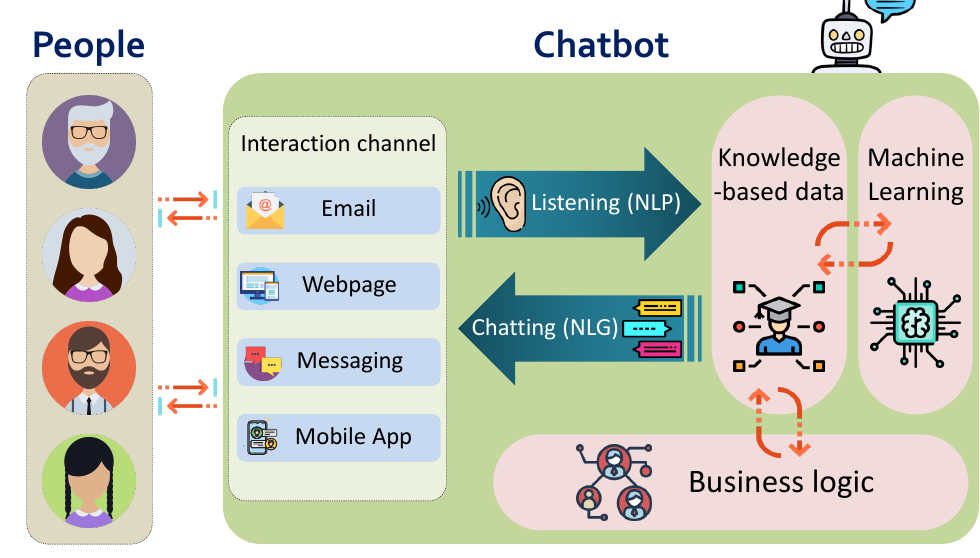
Figure 1. Anatomy of a